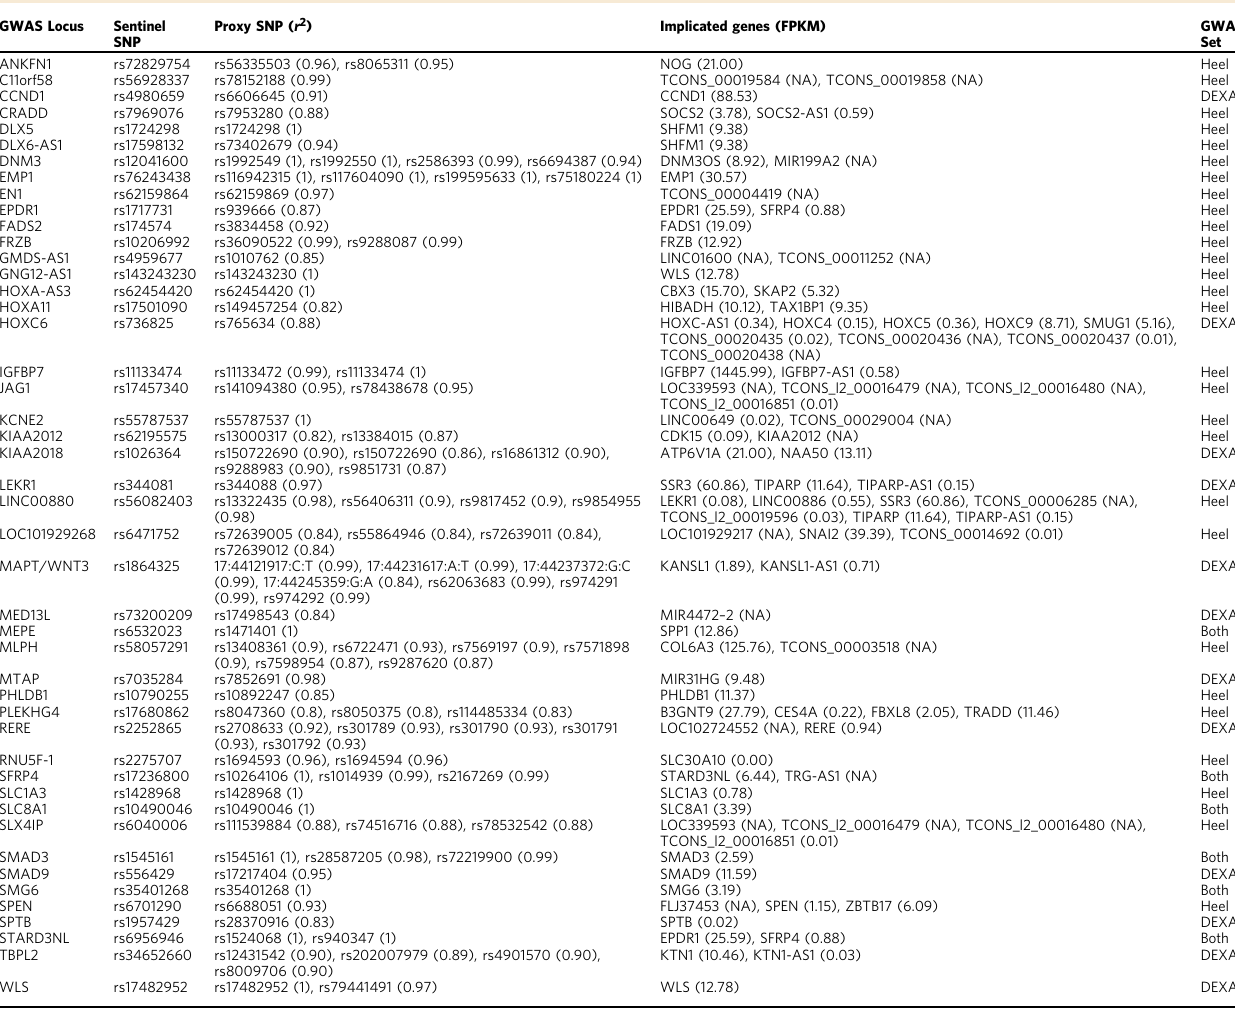
For each locus,proxy SNPs inopen chromatin looping toan open promoterare reported, togetherwith theirsentinel SNPsand the associated GWASloci. Looping interactions and open chromatinmaps were derived from promoter-focused Capture C and ATAC-seq experiments on hMSC-derived osteoblasts cultures from 3 or more individuals. Average expressions (in FPKM) of the target genes in hMSC-derived osteoblasts from RNA-seq experiments from the same 3 individuals are also